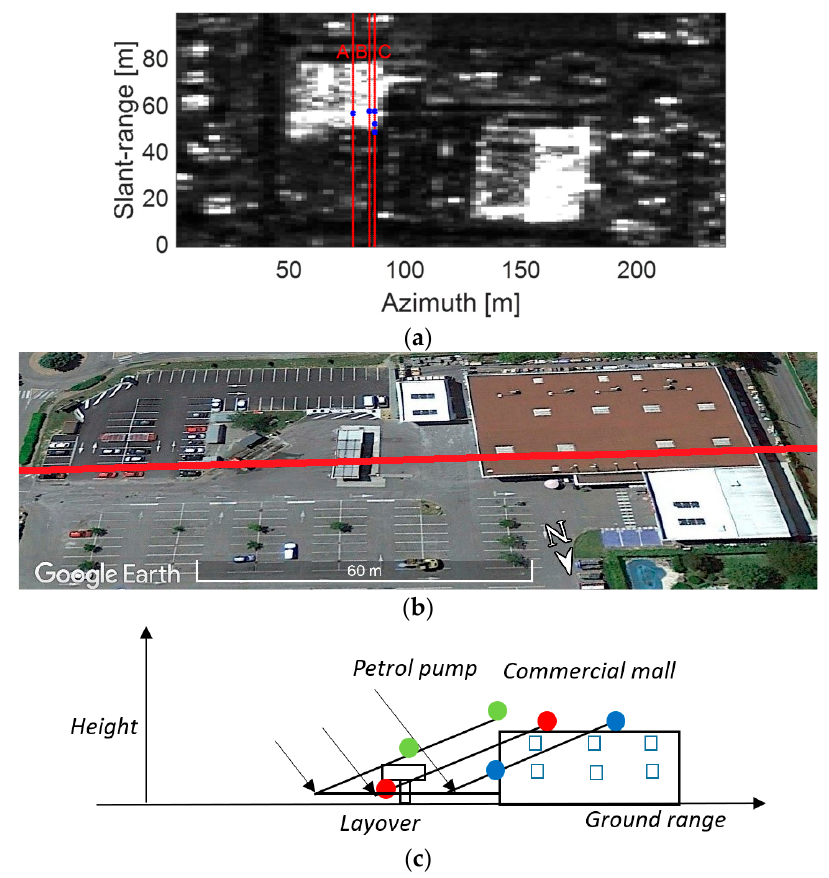
Figure 7. ( a ) Intensity HH image of the test area near Toulouse, with three range lines highlighted in red (A, B, C), ( b ) range line C reported on the optical image, ( c ) schematic geometrical diagram of the scene.